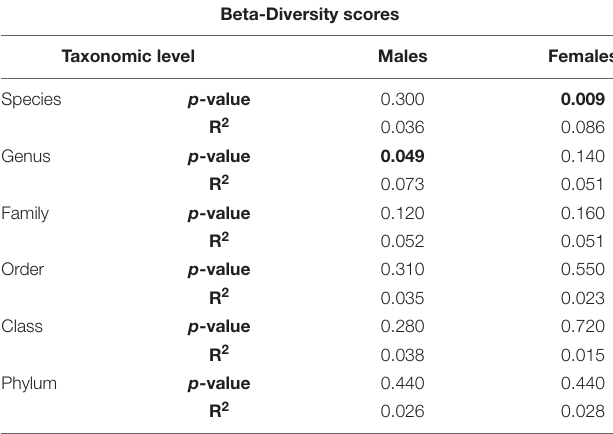
TABLE 2 | Microbiome beta-diversity did not significantly associate with short chain fatty acid (SCFA) treatment in both male and female